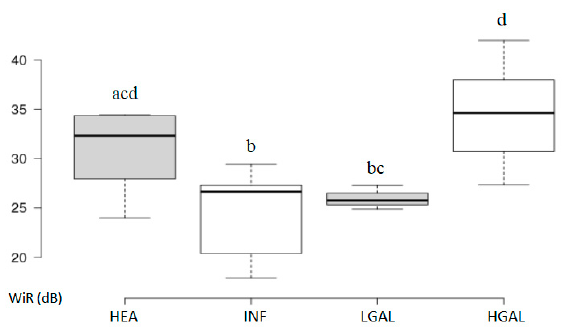
Figure 9. Box and whisker plot of the peak enhancement (PE) for healthy (HEA), inflammatory (INF), low-grade alimentary lymphoma (LGAL) and high-grade alimentary lymphoma (HGAL). a,b,c,d Values with different superscript letters differ significantly ( p < 0.05).